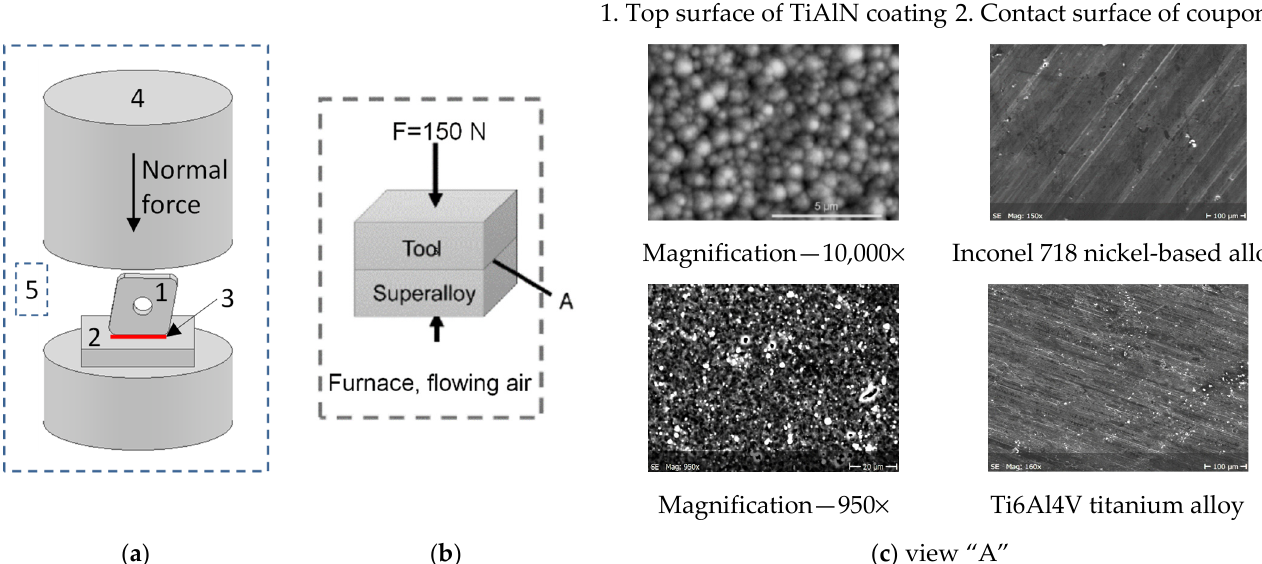
Figure 1. Schematic setup of static diffusion couple test ( a ) test conditions; ( b ) contact surfaces; ( c ) 1, cutting insert; 2, Inconel 718/Ti6Al4V coupons; 3, diffusion bond; 4, ceramic mass; 5, furnace with flowing oxygen; A, interface of diffusion couple.